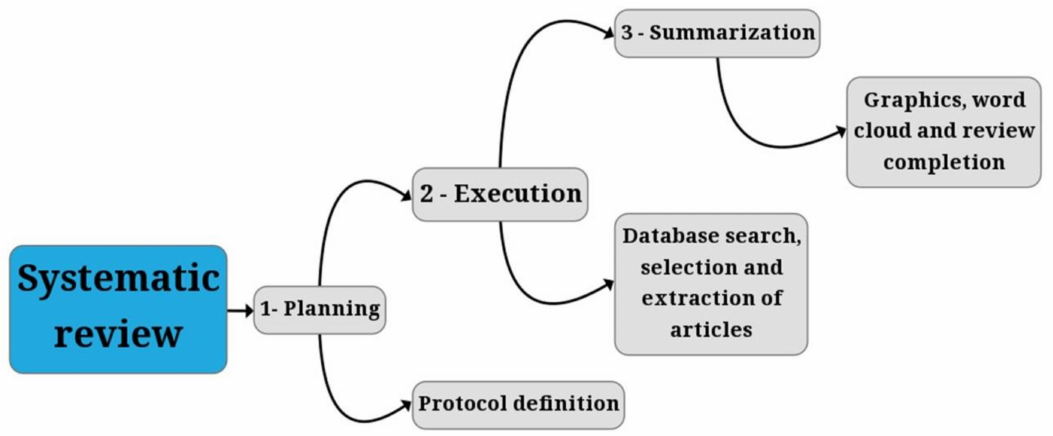
Figure 1. General systematic literature review flowchart. Source: author’s compilation.